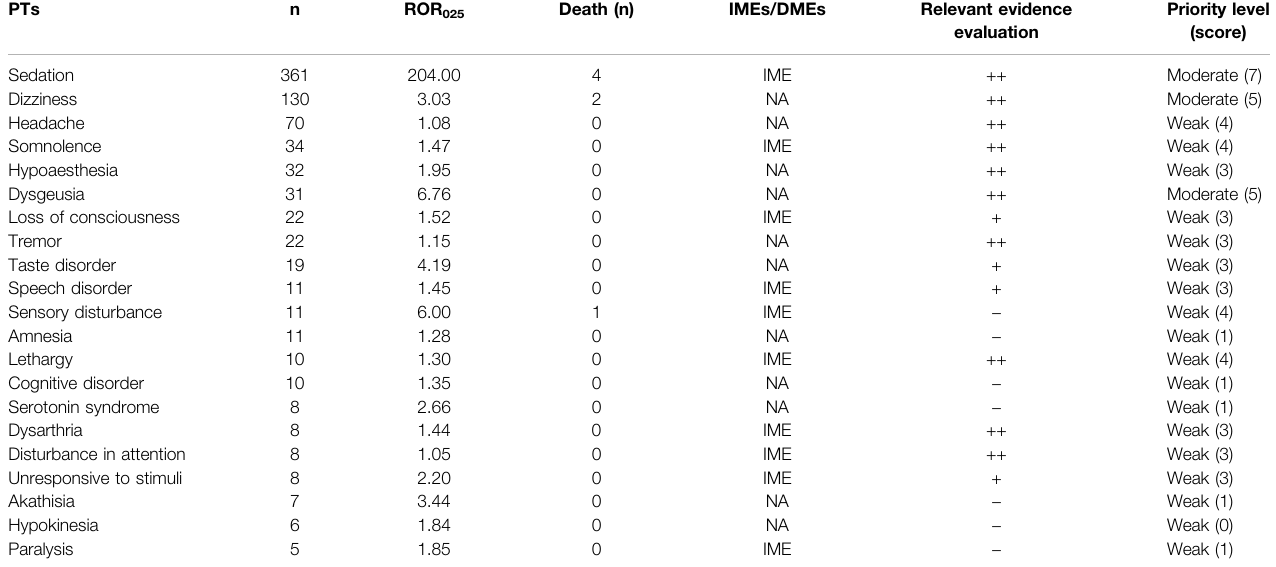
A priority score between 8 and 10, 5 – 7 or 0 – 4 represents the signal with strong, moderate or weak clinical priority, respectively. NA, Not Applicable (for relevant criterias); n, number of cases; PTs, Preferred Terms; ROR 025 , the lower limit of 95% con fi dence interval of ROR.